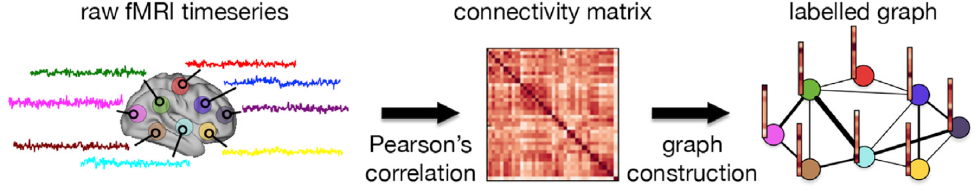
Figure 4. Estimation of single subject connectivity matrix and labelled graph representation. Pear- son’s correlation coefficient is used to obtain a functional connectivity matrix from the raw f MRI time series. Image taken from [70]